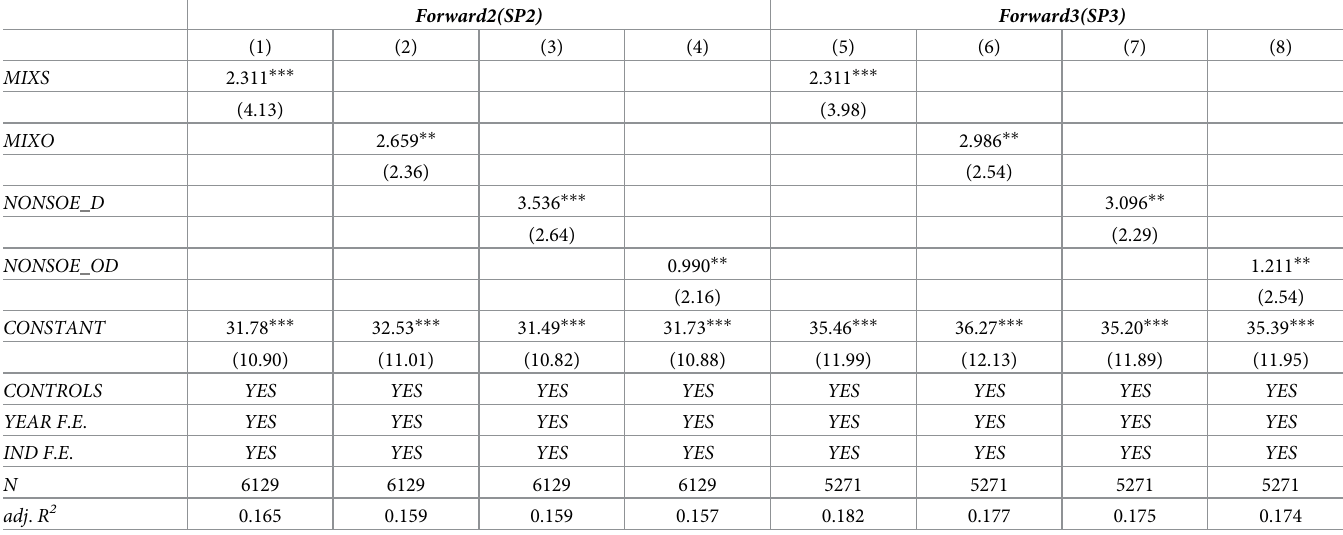
Table 6. The regression results of multiple-period forwarded explained